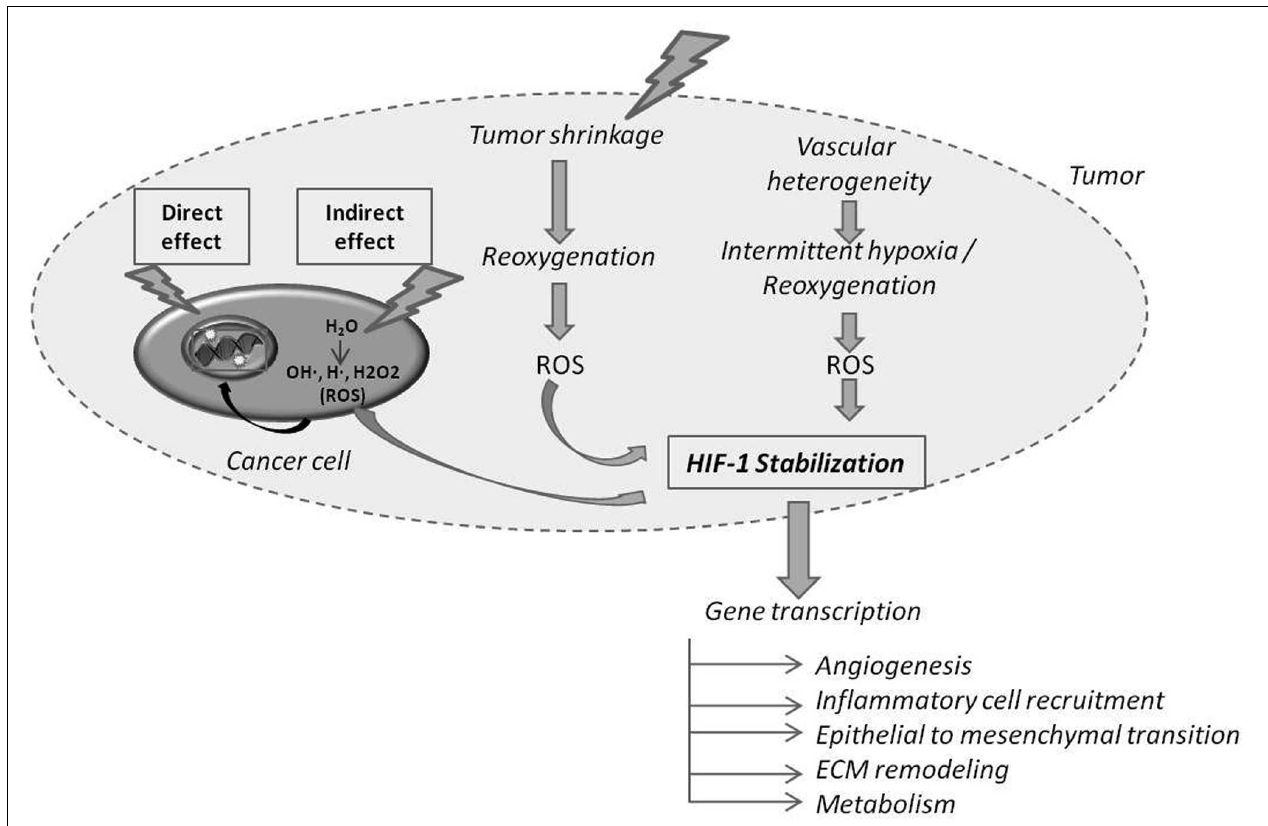
FIGURE 1 | Direct and indirect effects of radiotherapy (RT) on cancer cells and on tumor hypoxia and oxygenation. Ionizing radiations can directly hit DNA or participate to water radiolysis generating Reactive Oxygen Species (ROS) that in turn hit DNA. The RT-induced cancer cell death of the most oxygenated cells leads to the reoxygenation of hypoxic cells. Reoxygenation favors ROS production, which in turn stabilizes Hypoxia Inducible Factor-1 (HIF-1). HIF-1 target genes are implicated in several indicated